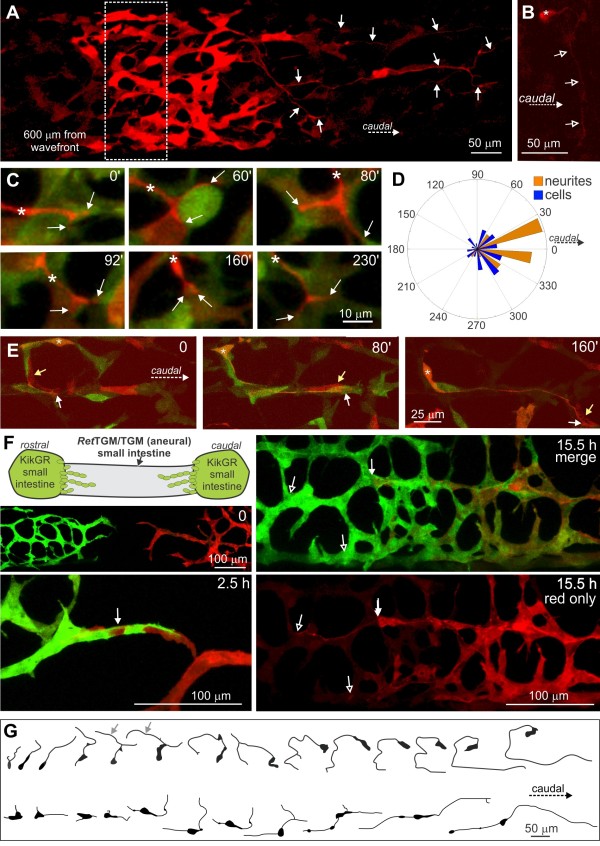
Behavior of neurites. A. A total of 5.5 hours following photoconversion of the entire diameter of the E12.5 colon (hashed box), 600 μm from the wavefront. Numerous neurites (white arrows) were present on the caudal side. More cells migrated caudally than rostrally. B. A neuron with a circumferentially projecting neurite in the E12.5 proximal colon. C. Neurites do not normally explore outside of the ENCC network. Growth cone of a neurite in the E12.5 colon, which was often bifurcated (arrows), and only explored within the ENCC network. The main shaft of the neurite is marked by an asterisk. D. Polar frequency histogram showing the direction of neurite advance (n = 9) and migrating ENCCs (n = 6) measured at 10-minute intervals. The directions of neurite advance were significantly different from ENCC migration direction (Watson’s U2 test for angles). E. Close association between a growing neurite and an individual ENCC. The growing tip (white arrow) of the neurite (orange) initially extends circumferentially and then the neurite extends caudally. It grew in close association with a photoconverted (red) ENCC (yellow arrow) for over 2.5 hours. The neuron cell body (asterisk) also migrates. F. Segments of Ednrb-hKikGR small intestine were placed at both ends of an explant of RetTGM/TGM small intestine, which lacks ENCCs. When ENCCs from the two populations were approximately 100 μm apart, the rostrally migrating population was photoconverted (time = 0). When the two populations collided, chains of intermingled cells formed (arrow, 2.5 h). Both populations then ceased to advance, although red neurites (open arrows) continue to grow rostrally for over 15 hours, well beyond the most rostral ENCC (arrow). G. Tracings of two ENCCs in the initial stages of neurite projection that were imaged for 12 hours (top cell) and 7 hours (bottom). ENCCs, enteric neural crest-derived cells.